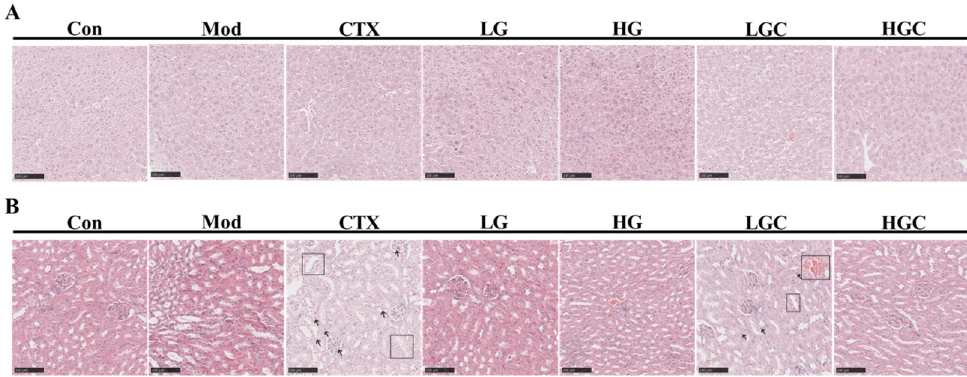
Figure 6. Histological analysis of liver and kidney. ( A ) H&E staining analysis of liver tissues. ( B ) H&E staining analysis of renal tissues in different groups of mice. Scale bar, 100 μ m.